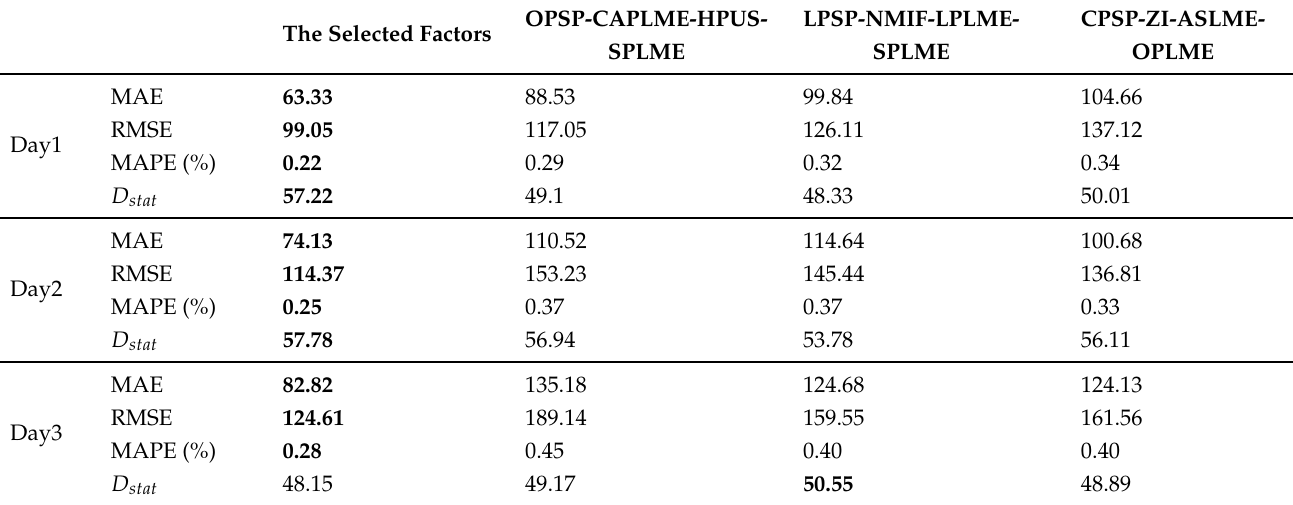
Table 4. Forecasting performance evaluation matrix under different factor